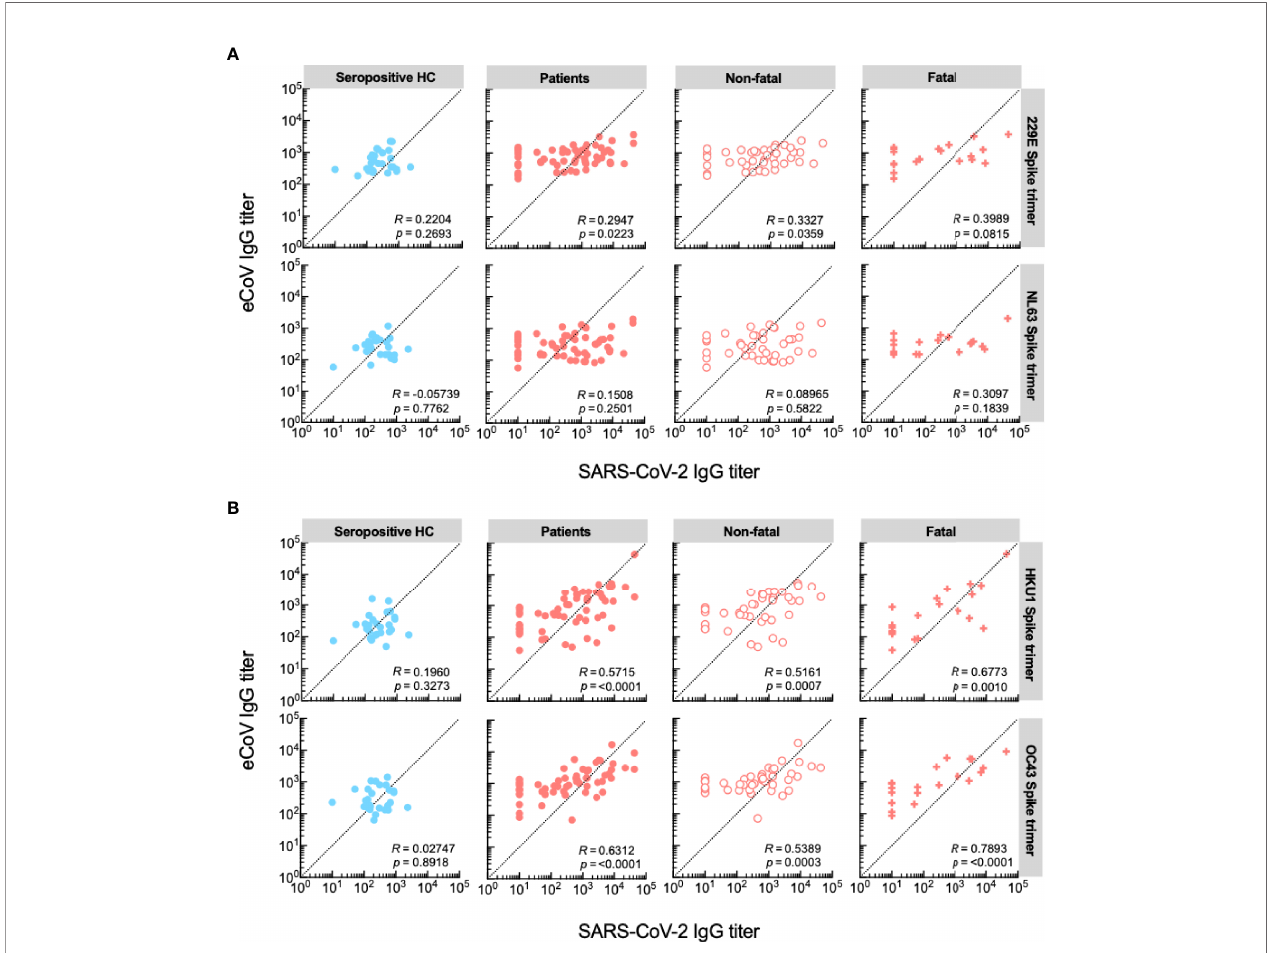
FIGURE 3 | IgG titers against eCoVs of the genus Betacoronavirus correlate in patients with a fatal disease outcome. (A) Correlations between serum IgG responses against SARS-CoV-2 and eCoVs of the genus Alphaviruses. (B) Correlations between serum IgG responses against SARS-CoV-2 and eCoVs of the genus Betaviruses. Spearman ’ s rank correlations are shown for each pair of spike trimer antigens, presented as R value and signi fi